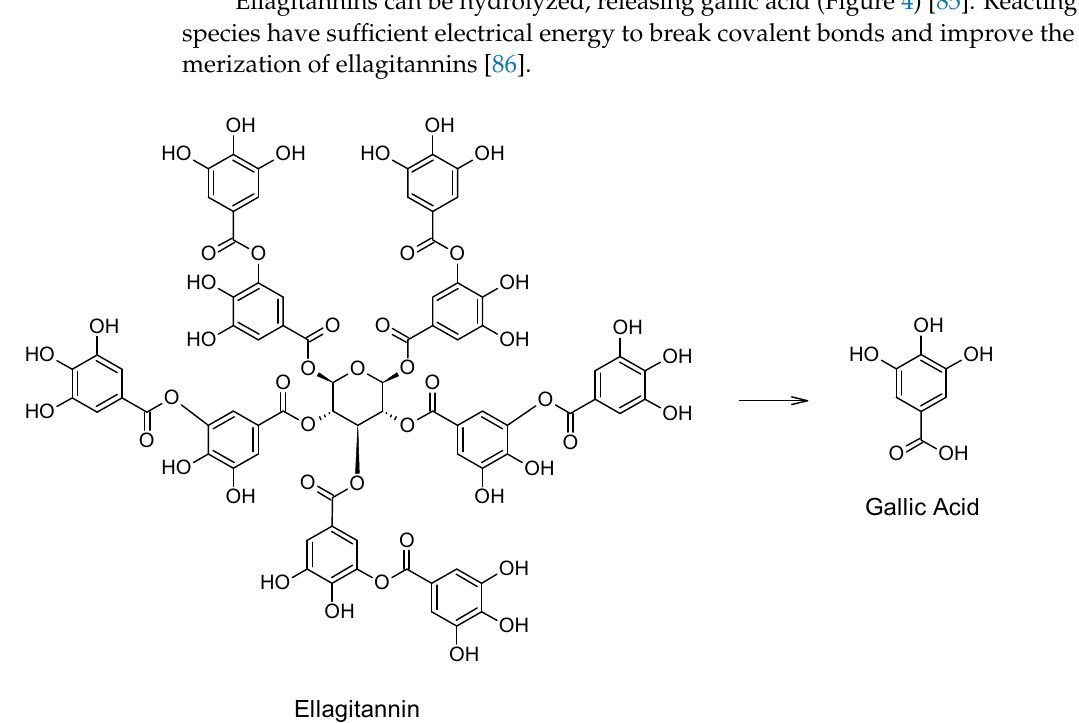
Figure 4. Depolymerization of ellagitannin [86].